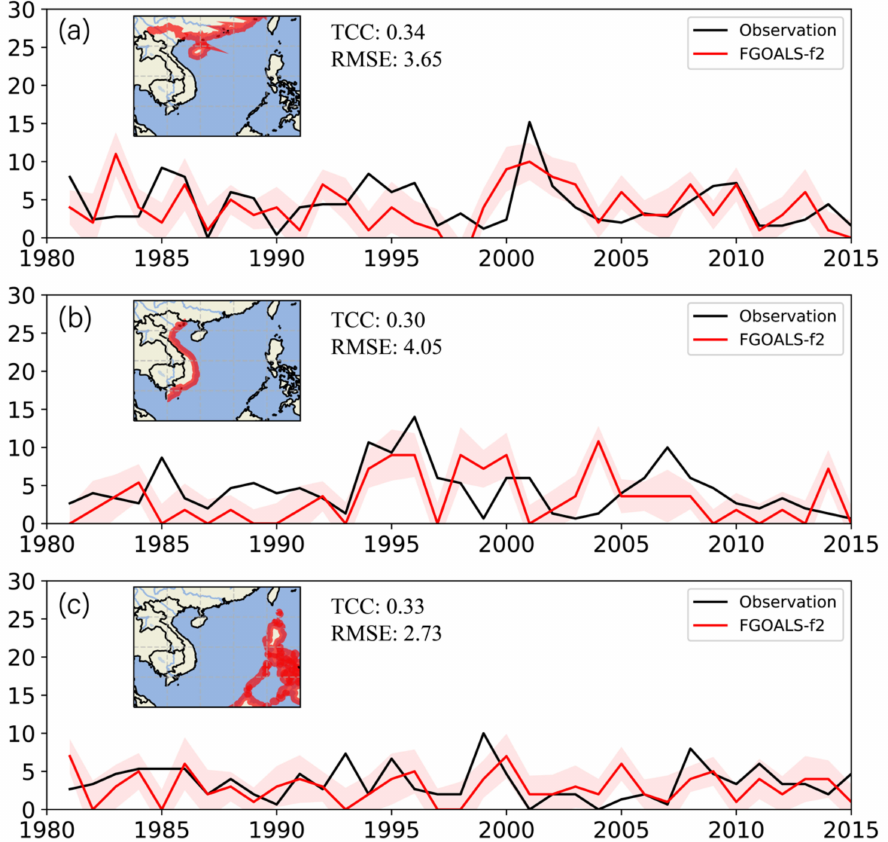
Figure 4. The interannual variability in the number of landing TCs in the southeast coast of China ( a ), the Indochina Peninsula ( b ), and the Philippines ( c ) from July to November during 1981–2015. The temporal correlation coefficient (TCC) and root mean square error (RMSE) of the interannual variability in the landing number and ACE of TC between the IBTrACS and FGOALS-f2 are also